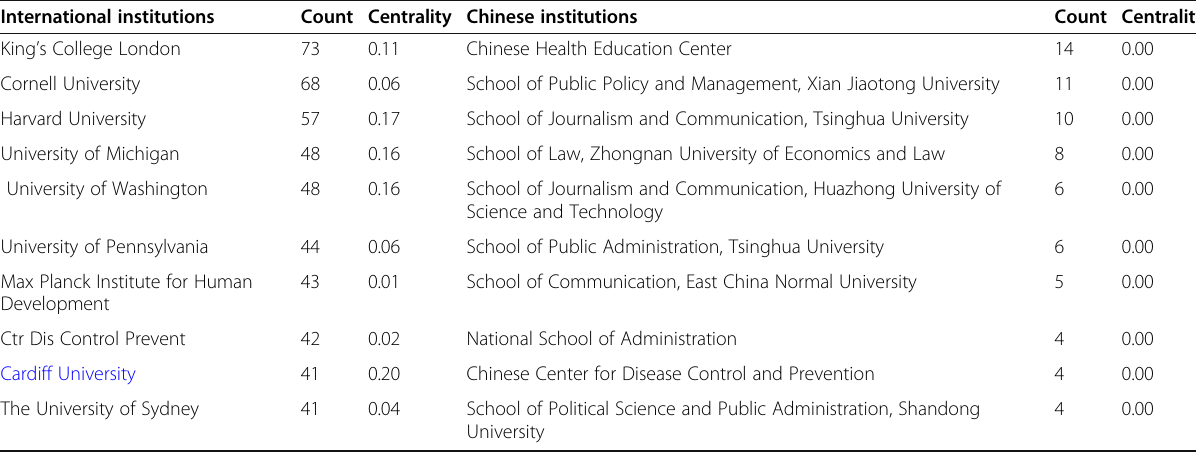
Table 1 The volume and centrality of domestic and international risk communication